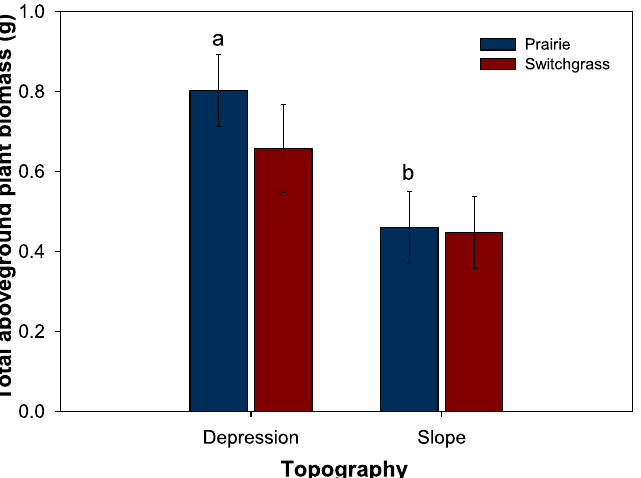
Figure 5. Total aboveground biomass of switchgrass plants grown in the studied soil cores from depression and slope topography in prairie (blue) and switchgrass (red) cropping systems. Data shown are means ± SE (n = 6). Letters indicate significant differences between topographical positions within each system.